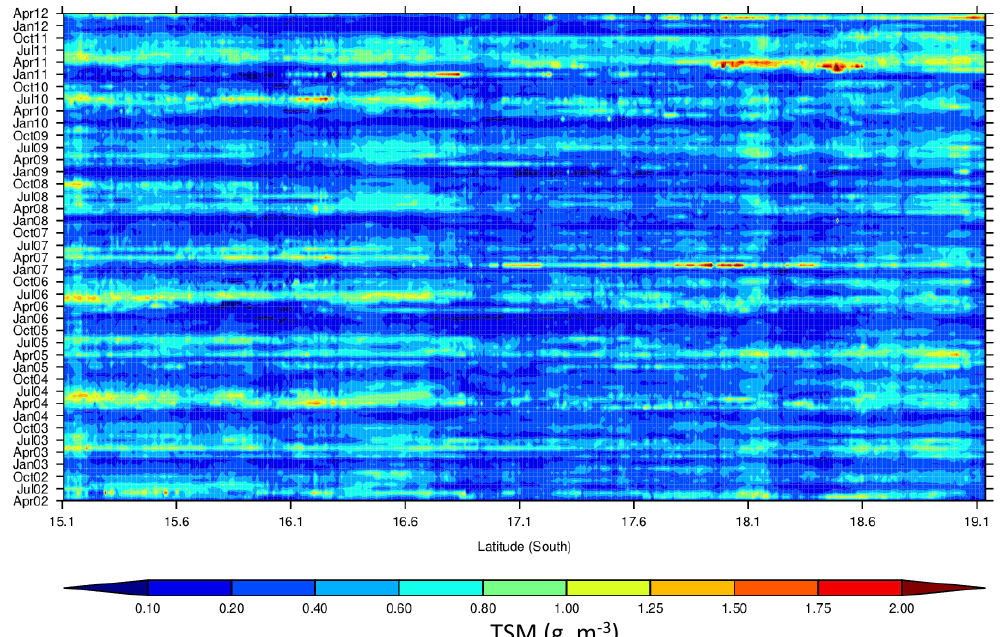
Figure 17. Latitude-time plot of TSM for the GBRW